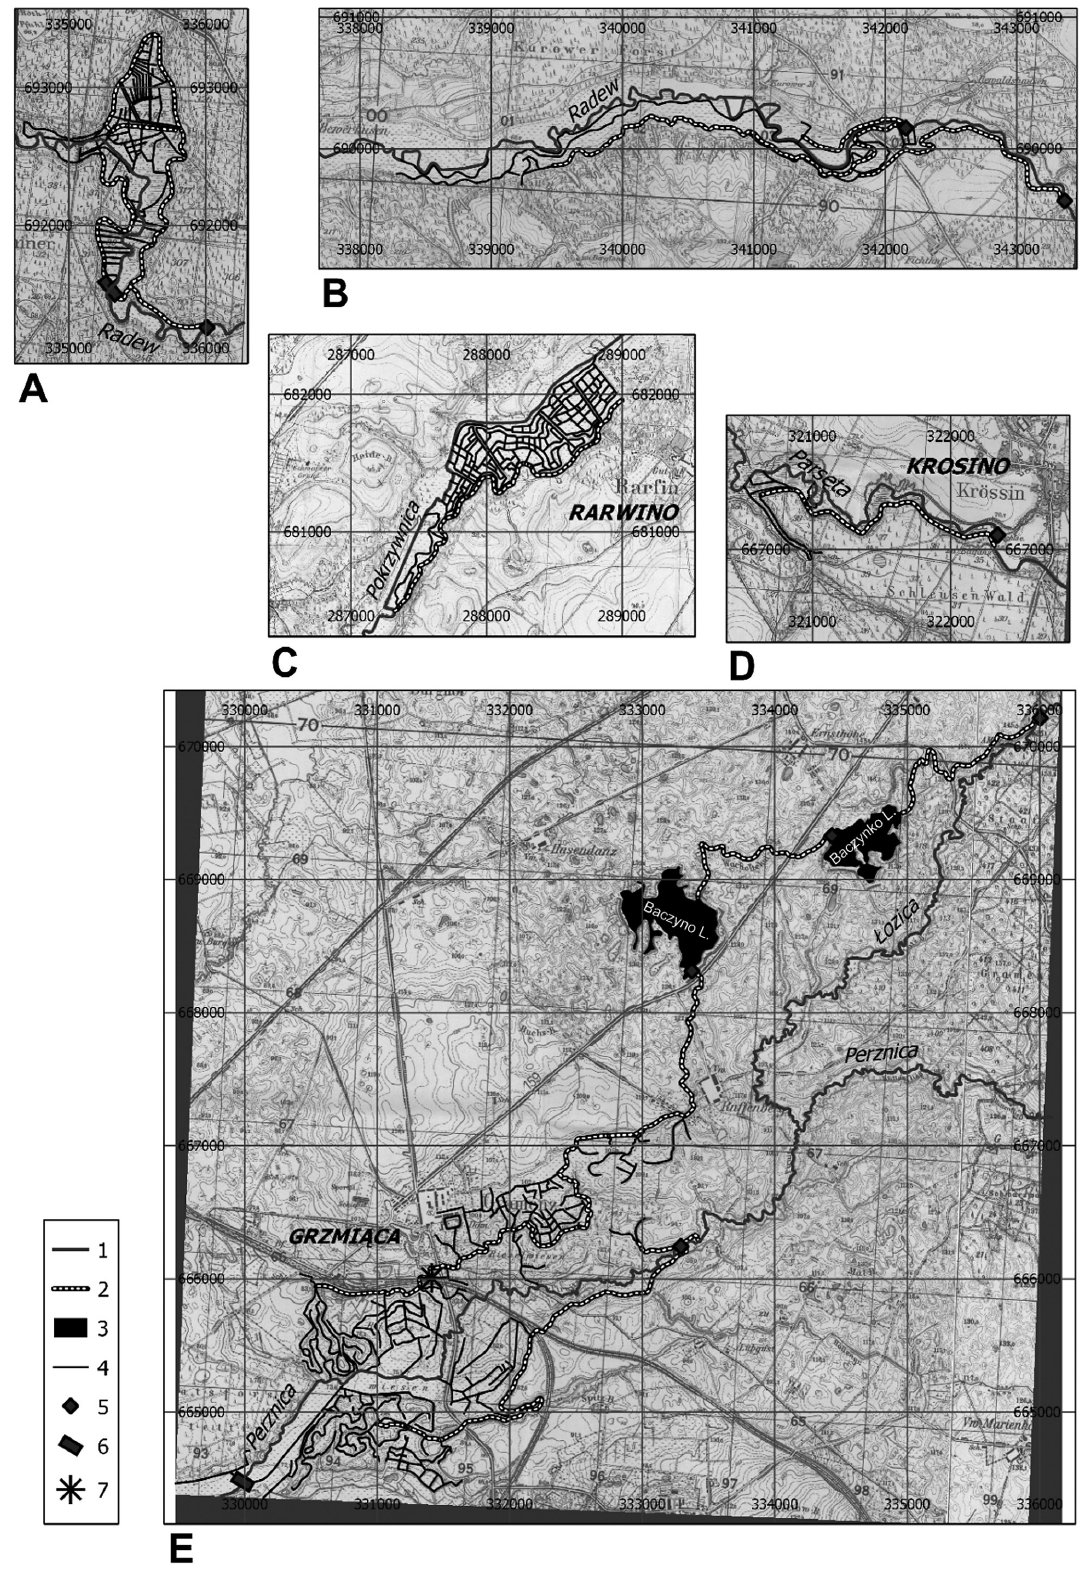
Fig. 3. Irrigation systems at the Parsęta catchment on the basis of the archival topographic maps (30s of the 20 th century). 1 – main rivers, 2 – main canals, 3 – retention reservoirs, 4 – irrigation ditches, 5 – main weirs, 6 – aqueducts, 7 – water mill. A–E – location of the research areas from Fig. 1. A – Radew (Kępiste), B – Radew (Kurowo), C – Pokrzywnica (Rarwino), D – Parsęta (Krosino), E – Perznica and Łozica